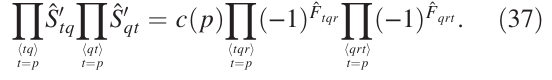
FIG. 9. The interpolating vector field lies parallel to the branching structure for both o There are no singularities of the vector field away from the vertices. ˆ U on link h pq i depends on the pq ˆ X is always pq ˆ Z acts on the link connecting the first